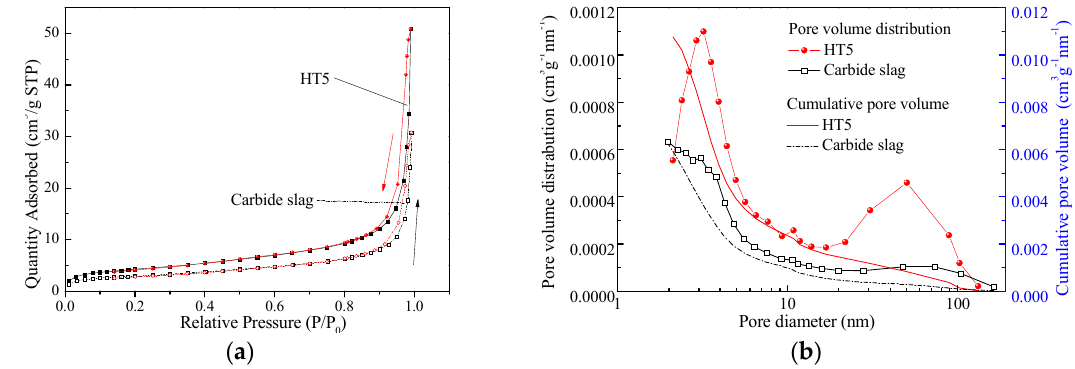
Figure 12. Pore characteristics of HT5 and carbide slag: ( a ) N 2 adsorption–desorption isotherms, ( b ) pore volume distributions after 10 cycles (carbonation in 15% CO 2 /N 2 at 700 °C for 20 min, calcination in 70% CO 2 /N 2 at 920 °C for 10 min). Table 4. Surface areas and pore volumes of HT5 and carbide slag (carbonation in 15% CO 2 /N 2 at 700 °C for 20 min, calcination in 70% CO 2 /N 2 at 920 °C for 10 min). Samples N